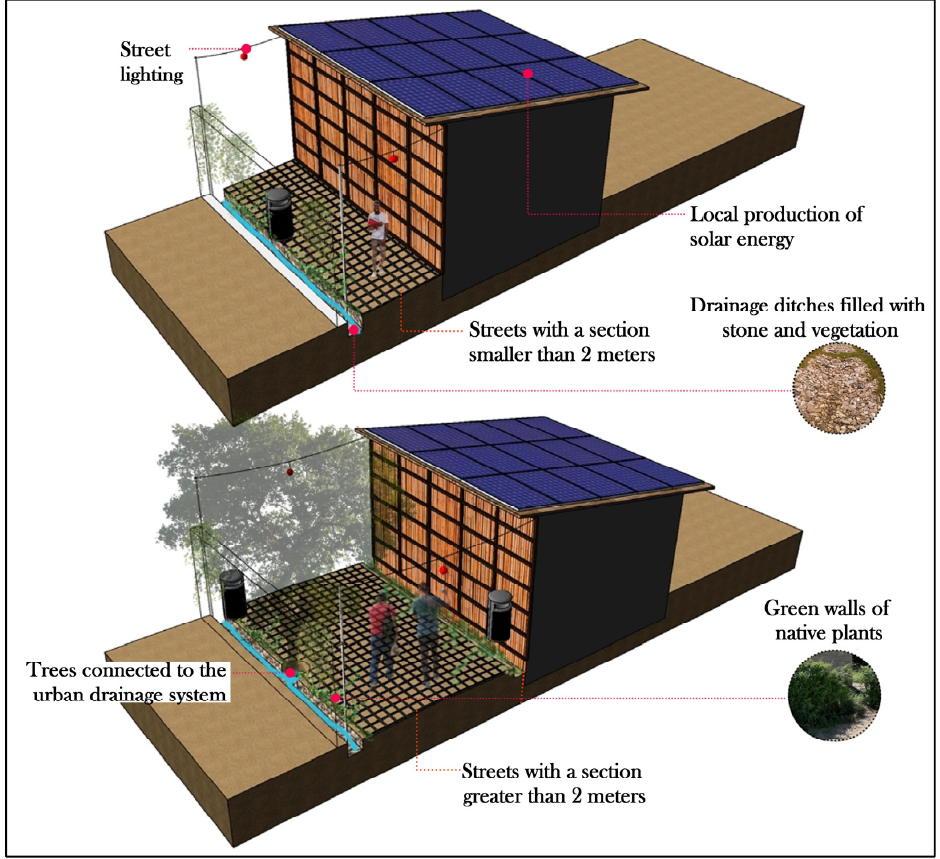
Figure 13. Infrastructural interventions.